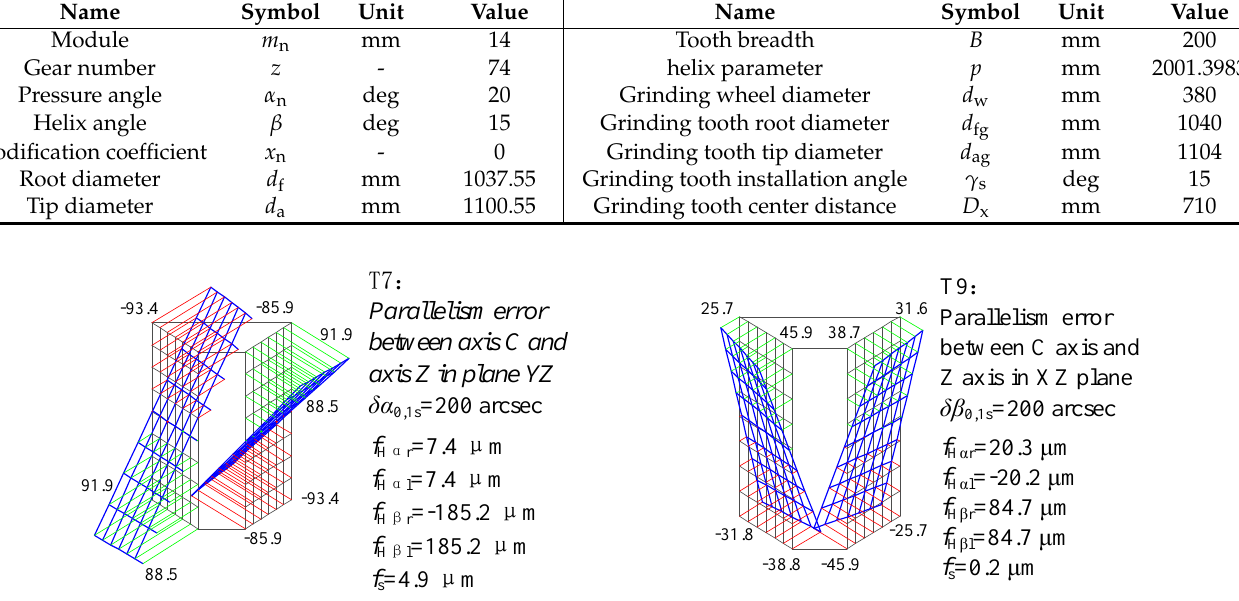
Figure 7. Deviations in tooth surface produced by assembly errors T7 and T9.